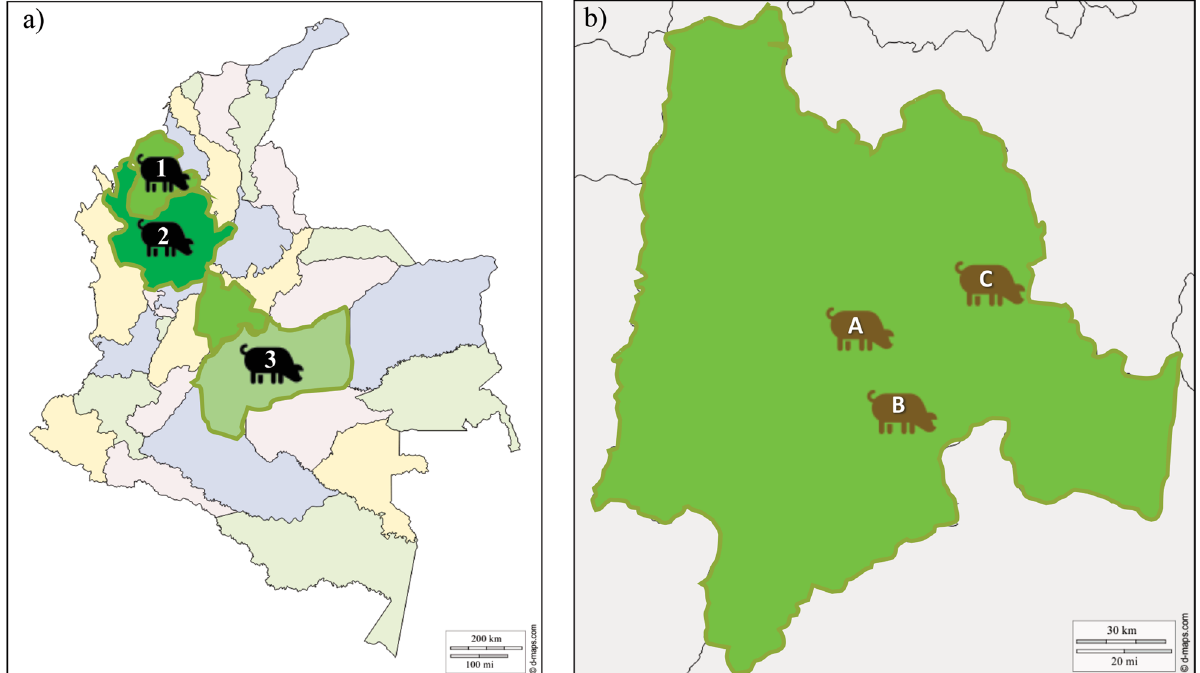
Figure 1. Sampling location sites. ( a ) Map of Colombia showing the location of AGROSAVIA’s research centres (I.C) having creole pig populations (pictogram in black), 1 = Zungo (IC Turipaná, Córdoba, n = 26), 2 = San Pedreño (IC El Nus, Antioquia, n = 35) and 3 = Casco Mula (IC La Libertad, Meta, n = 30) 82 . ( b ) Enlargement of the Cundinamarca department showing the location of the commercial line population (pictogram in brown), A = El Remanso-U.D.C.A (n = 31), B = Ubaque (n = 35) and C = Manta (n = 31). These free maps were downloaded from d-maps (https ://d-maps.com/); the images are freely available and modifiable in accordance with d-maps policies 83,84 . Maps were modified using PowerPoint Software (Version 2002) Microsoft Office 365 ProPlus (U.D.C.A institutional license) by